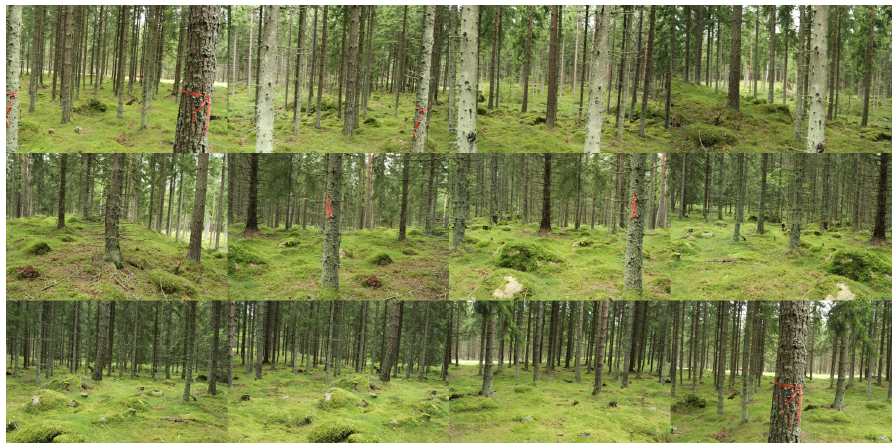
Figure 11. Center camera images from field Plot 165 with clearly visible stems. The individual images were acquired from the center of the field plot in a counter-clockwise panorama-style acquisition protocol in steps of approximately 30 degrees.